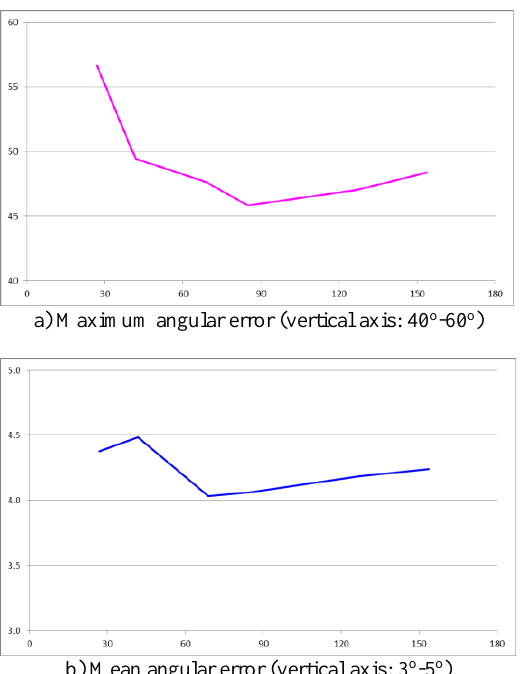
Figure 5. Angular error statistics. Horizontal axis: illumination azimuthal difference 0 o -180 o